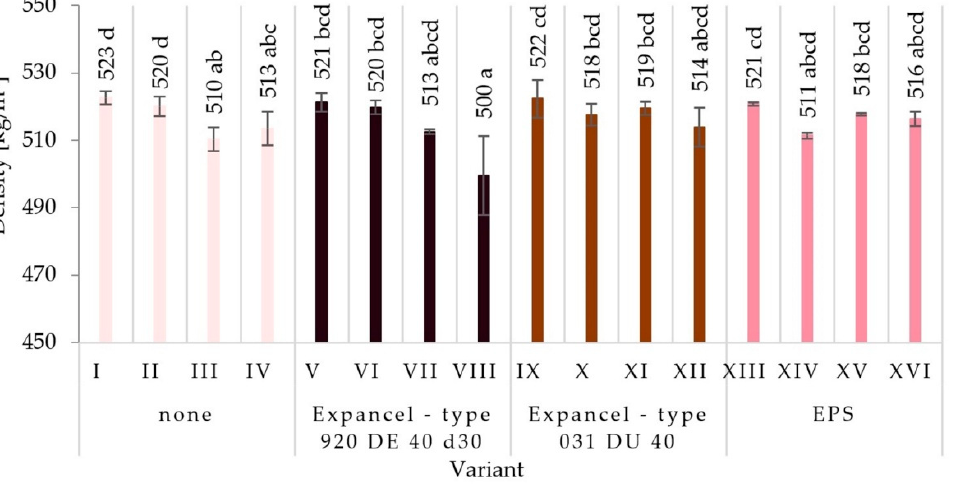
Figure 1. The density of the particleboards produced (means and standard deviation, a, b, c, ( . . . ). Homogeneous groups were determined by the Tukey test; different letters denote a significant difference; means followed by the same letter do not statistically differ from each